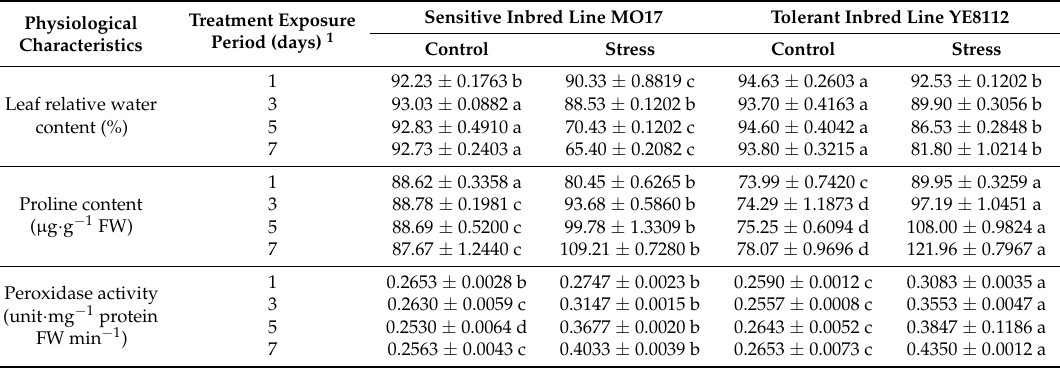
Table 1. Physiological responses of the two contrasting maize inbred lines to drought